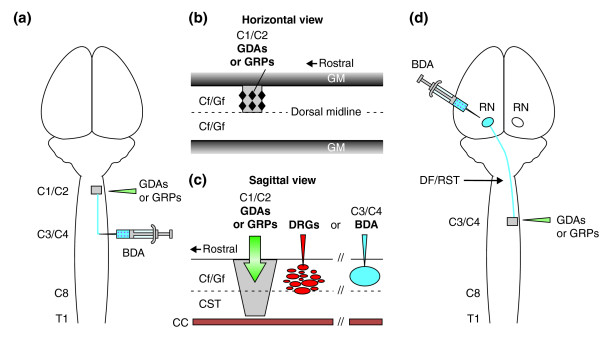
The models of spinal cord injury in adult rats used in this study. Schematic illustrations of (a-c) white matter of the dorsal column and (d) the dorsolateral funiculus white matter pathways of the spinal cord. (a,d) Dorsal views of the rat brain and spinal cord. (b) horizontal and (c) sagittal views of the dorsal column white matter pathways at the C1/C2 cervical vertebrae of the spinal cord. (a) Dorsal column white matter on the right side was transected (shaded area) at the C1/C2 spinal level, and the ability of either BDA-labeled endogenous axons or axons from microtransplanted GFP-expressing adult sensory neurons (DRGs) to cross injuries bridged with GDAs or GRPs was assayed. (b) Injections of GDA or GRP cells (black diamonds) suspended in medium were made directly into the centers of the injury sites as well as their rostral and caudal margins in the cervical spinal cord. (c) A discreet population of endogenous ascending axons within the cuneate and gracile white matter pathways of dorsal columns was labeled by BDA injection at the C3/C4 spinal level (5 mm caudal to the lesion site, shaded). Alternatively, microtransplants of GFP+ DRGs were injected 500 μm caudal to the injury site. (d) The right-side dorsolateral funiculus white matter containing descending axons of the rubrospinal tract was transected at the C3/C4 spinal level and GDAs or GRPs were transplanted as described for dorsal column injuries. To trace axotomized rubrospinal tract axons, BDA was injected into the left-side red nucleus (RN) 8 days before the end of each experiment. CC, central canal; Cf, cuneate fasciculus; CST, corticospinal tract; DF, dorsolateral funiculus; Gf, gracile fasciculus; GM, gray matter; RST, rubrospinal tract; T1, level of the first thoracic vertebra.